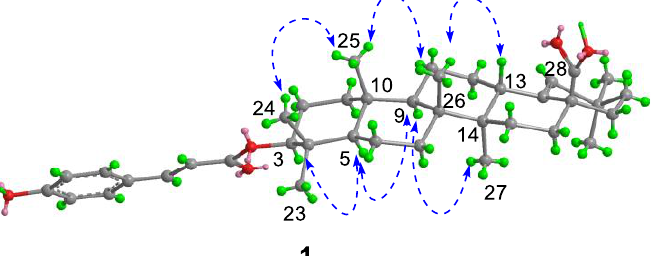
Figure 3. Key NOE correlations of 1 .